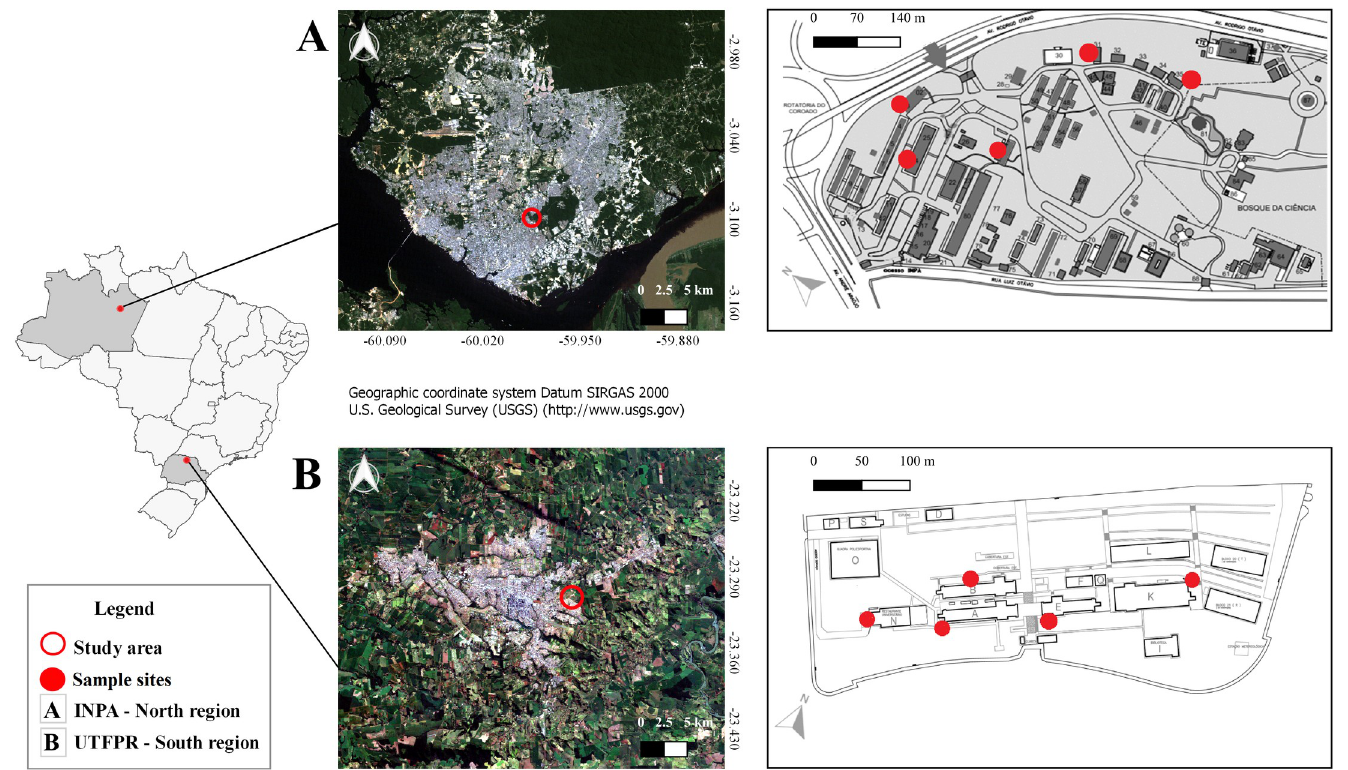
Fig 1. Location of the study area, demonstrating the distribution of the sample sites in the North and South Regions of Brazil. Source: https://earthexplorer.usgs. gov/.